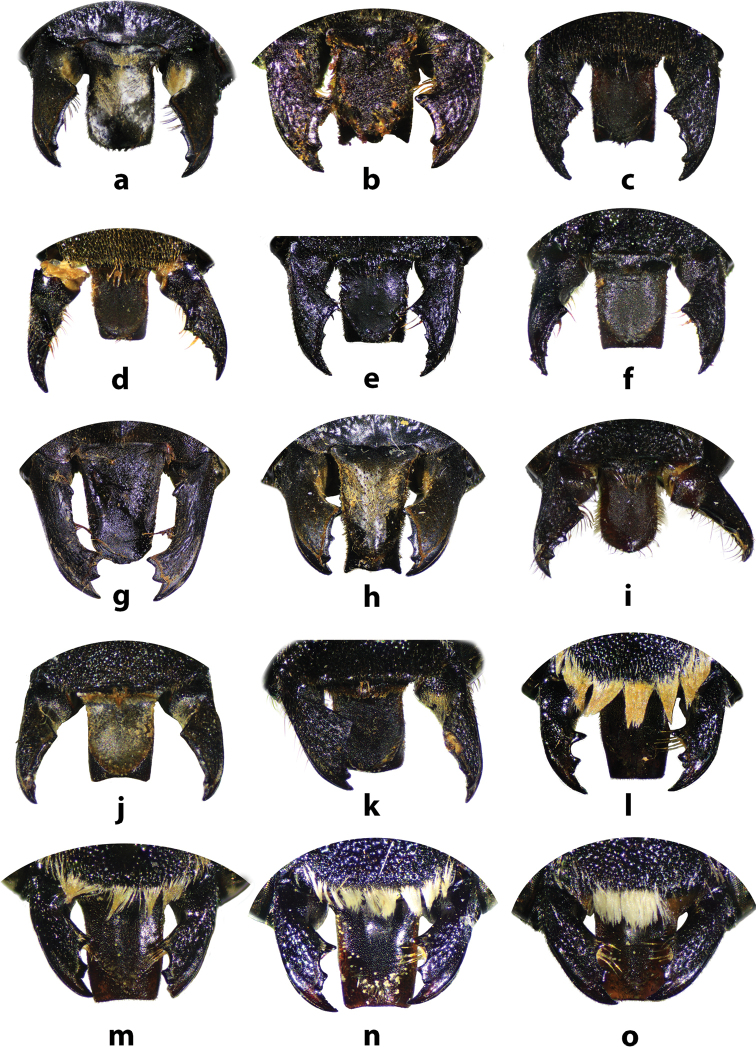
Distal edges of labrums and mandibles of some Thai Callomegachile (a–k females, l–o males) aM. (Callomegachile) atratiformisbM. (Callomegachile) chiangmaiensis sp. nov. c, lM. (Callomegachile) disjunctad, mM. (Callomegachile) facetaeM. (Callomegachile) fulvipennisfM. (Callomegachile) impressagM. (Callomegachile) monticolahM. (Callomegachile) odontophoraiM. (Callomegachile) parornataj, nM. (Callomegachile) umbripenniskM. (Callomegachile) umbripennis (BSRU AA-4620) oM. (Callomegachile) umbripennis (BSRU AA-3654, BSRU AA-3662 and KKIC-02).